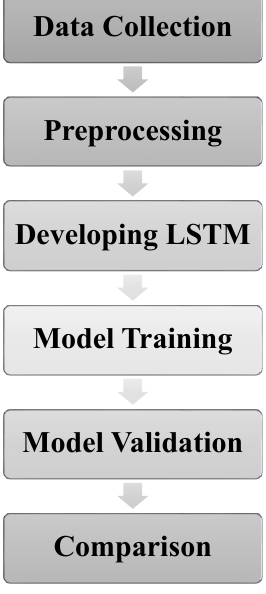
Figure 1. Research steps.